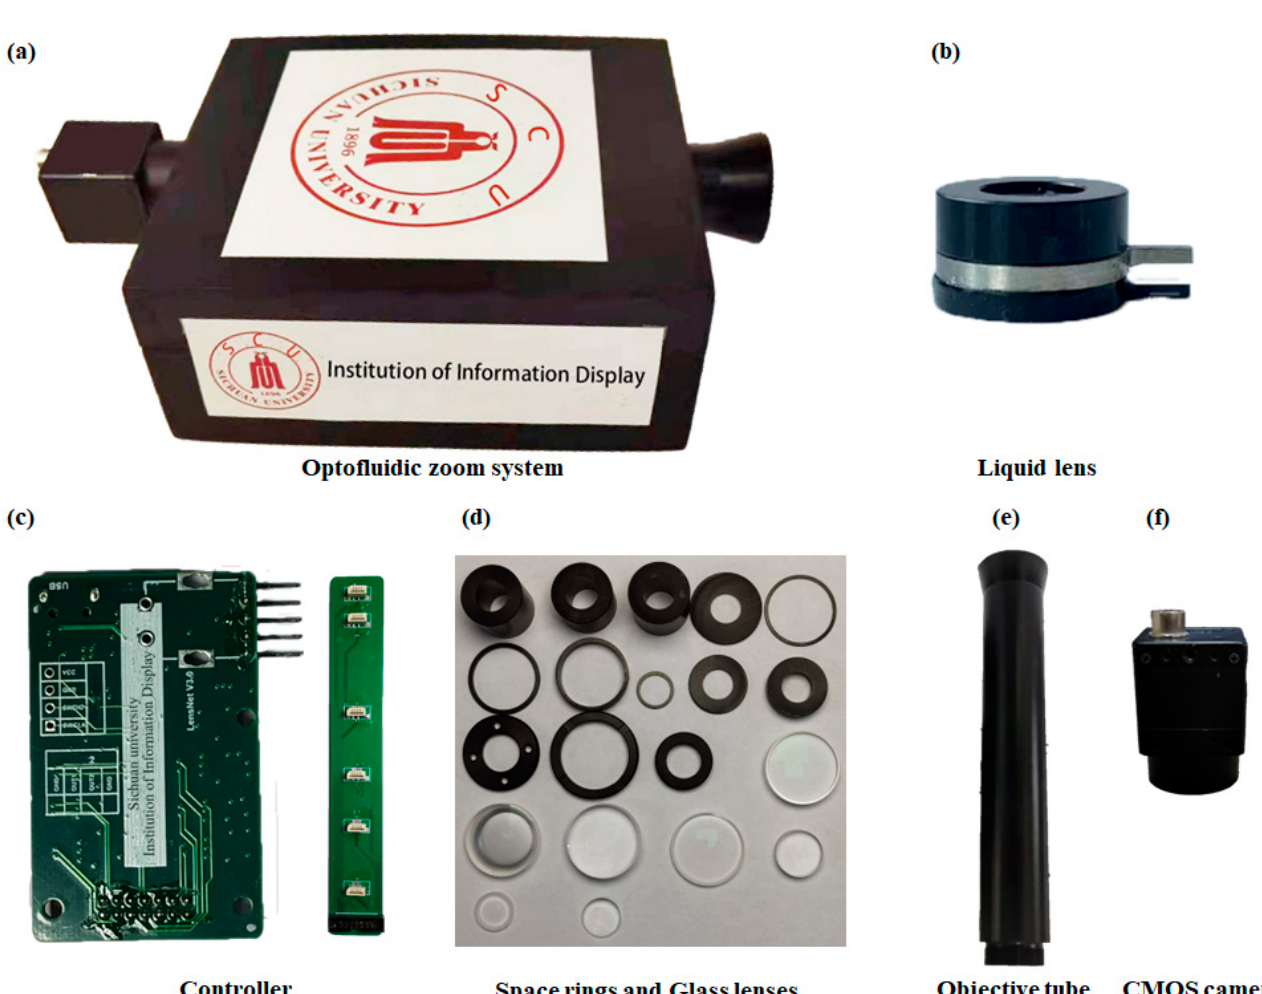
Figure 4. Fabricated device. ( a ) Optofluidic zoom system. ( b ) Liquid lens. ( c ) Controller. ( d ) Space rings and glass lenses. ( e ) Objective tube. ( f ) CMOS camera .